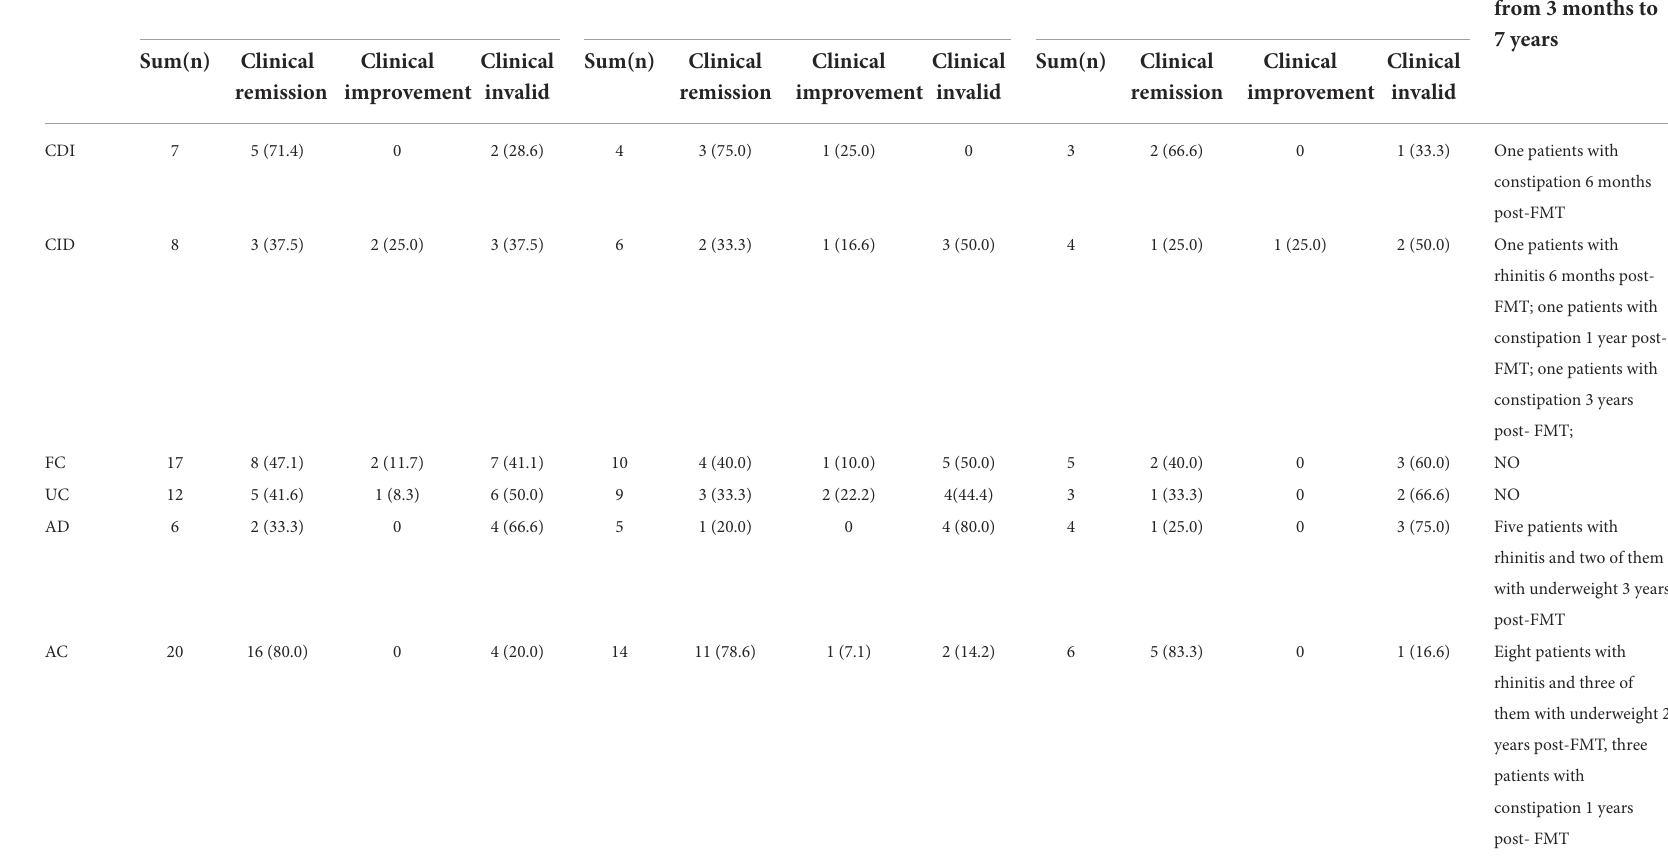
TABLE 5 Clinical efficacy of patients followed up after FMT T [cases n